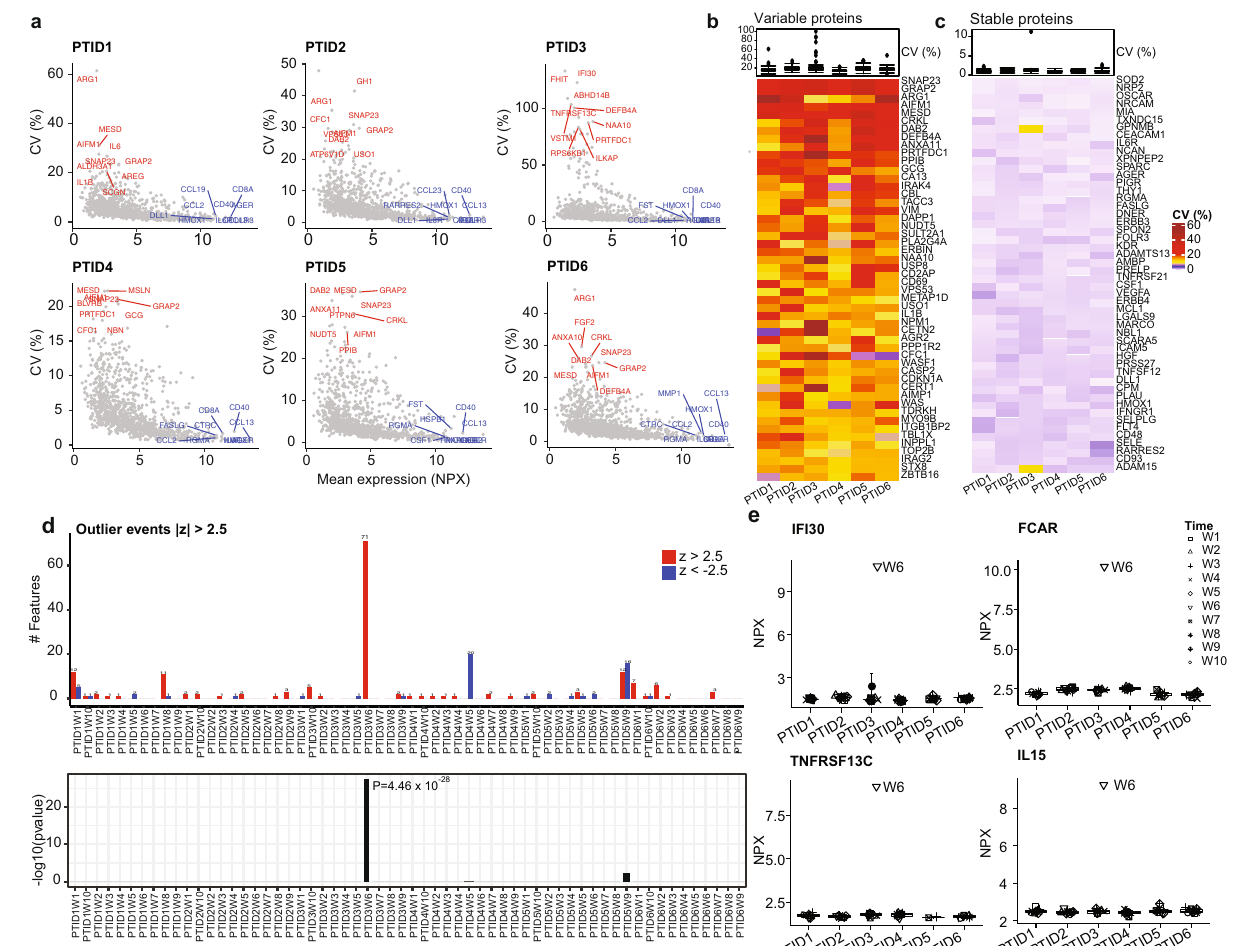
Fig. 3 | Longitudinal stability of plasma proteome. a Scatter plots of coef fi cient of variation (CV) versus mean of normalized protein expression (NPX) over 10 timepoints in n =6 participants. One plasma sample per week was collected from n =6 participants over 10 weeks. The evaluation for each participant was based on measurements on 1042 proteins in the corresponding 10 plasma samples. The longitudinal stable and variable proteins are represented in blue and red, respec- tively. b , c Heatmap of CV of top 50 longitudinally variable ( b CV>5%) or stable ( c CV<5%) plasma proteins. d Top panel: Number of proteins with z >2 : 5 (red)